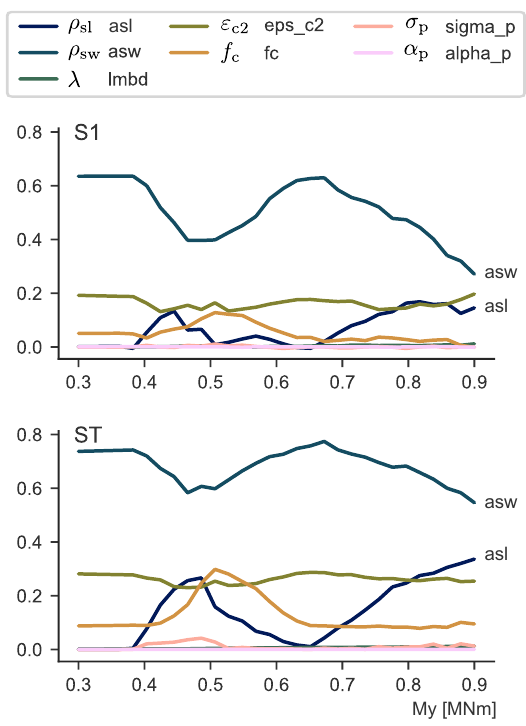
Figure 6. S2 Indices: Input Parameter interaction affecting k